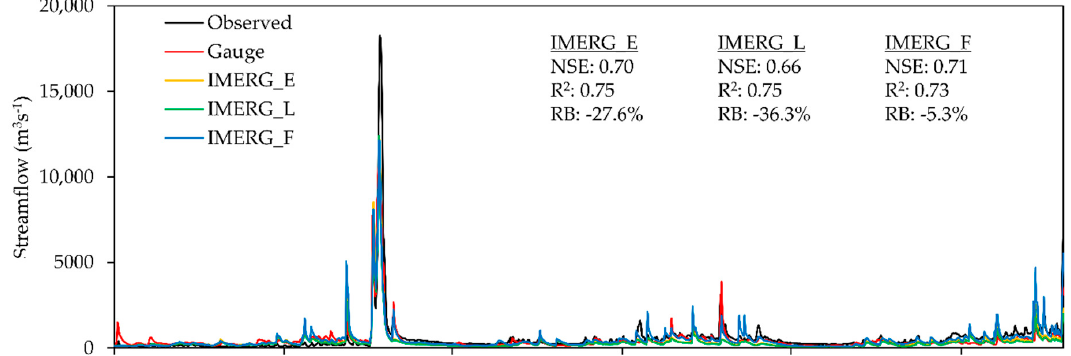
Figure 5. Hydrological reliability assessment of the GPM IMERG products in simulating daily streamflow at the Jambatan Guillermard using the SWAT model from 12 March 2014 to 31 December 2016.